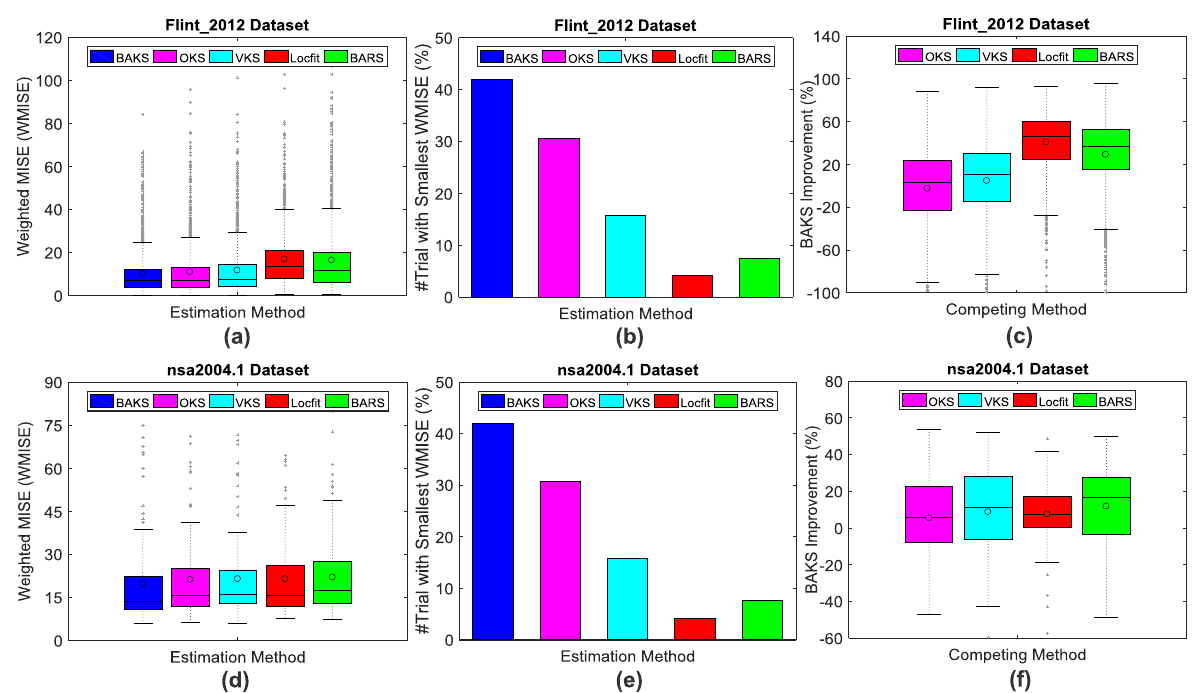
Fig 11. WMISE comparison across all firing rate estimation methods using real neural data. (a) Average WMISE comparison across all trials in Flint_2012 dataset. (b) Number of times (in %) BAKS outperforms other methods in Flint_2012 datasets. (c) Single trial performance improvement made by BAKS over competing methods in Flint_2012 datasets. (d)-(f) Similar to that of (a)-(c) but with nsa2004.1 dataset. In each boxplot, black lines show the medians; black circles indicate the means; colored solid boxes represent interquartile ranges; whiskers extend 1.5 × from upper and lower quartiles; gray crosses represent